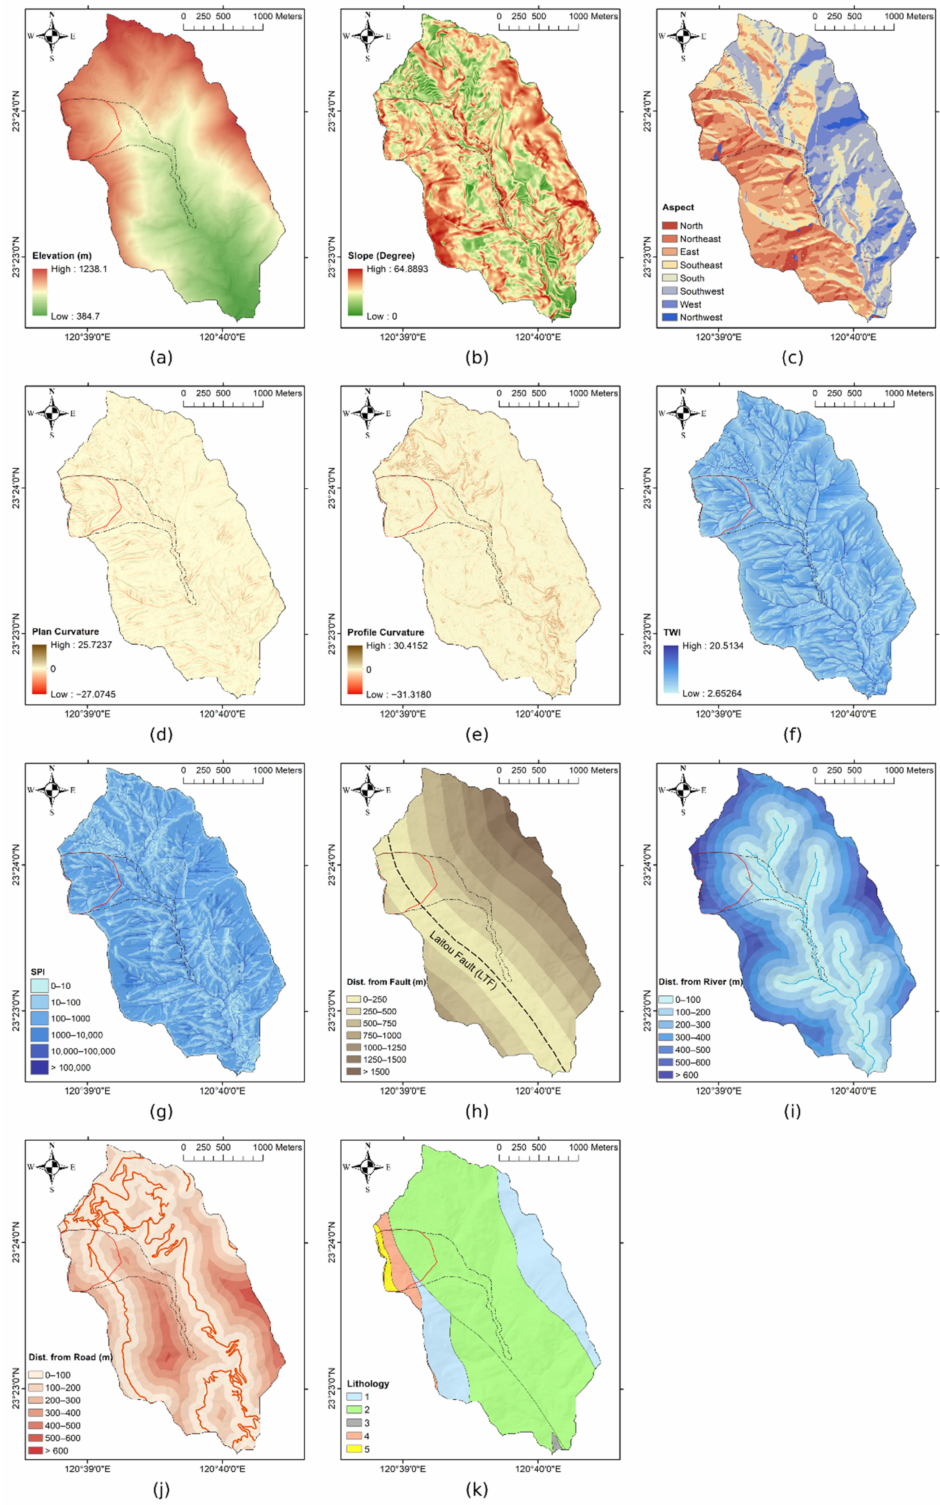
Figure 5. Topographic factors: ( a ) elevation; ( b ) slope; ( c ) aspect; ( d ) plan curvature; ( e ) profile curvature; ( f ) Topographic Wetness Index (TWI); ( g ) Stream Power Index (SPI); ( h ) distance from fault; ( i ) distance from river; ( j ) distance from road; ( k ) lithology. 1. Thick-bedded massive sandstone and argillaceous sandstone; 2. sandstone and sand-shale interbedding; 3. bodies of water; 4. massive shale, occasionally with thin-bedded siltstone; 5. siltstone and shale thin